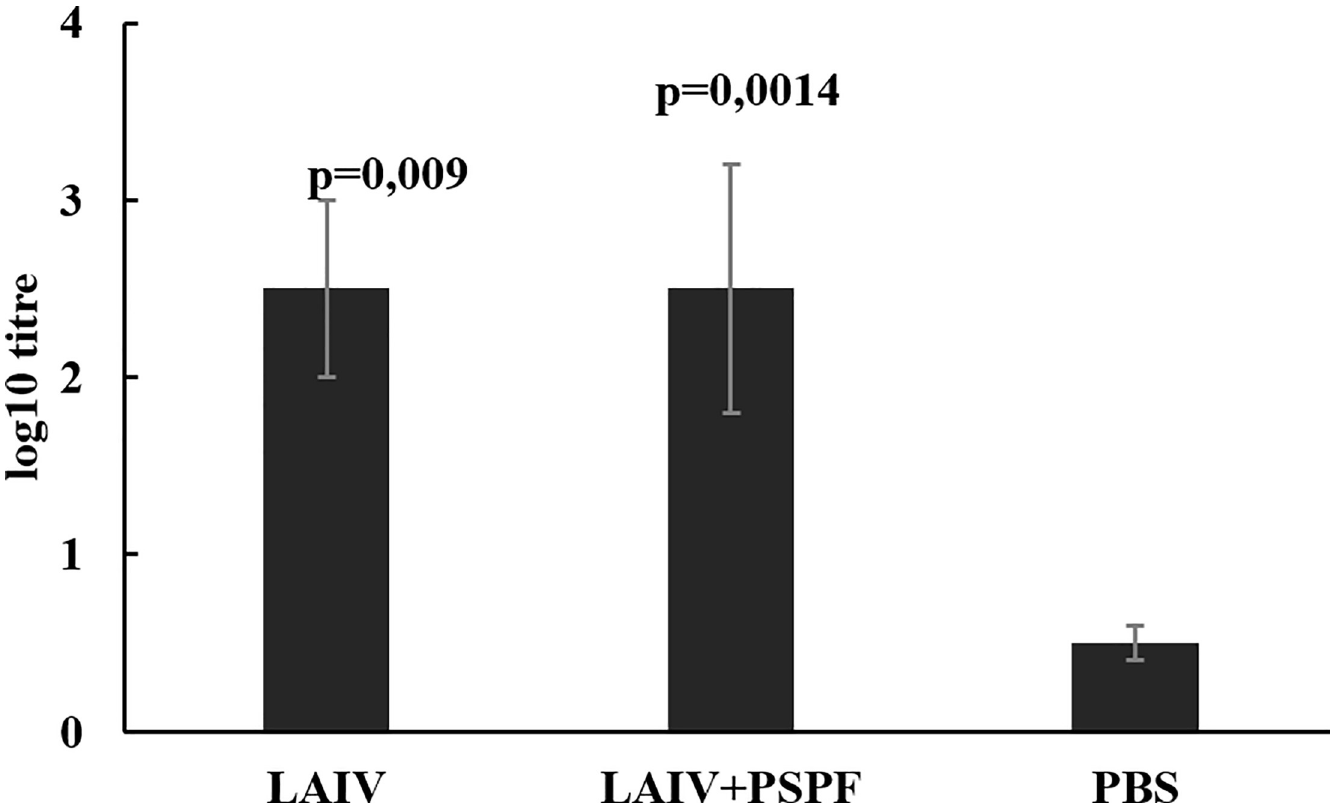
Fig 3. Virus-specific serum IgG immune responses in mice after primary vaccination and revaccination with LAIV or combined LAIV and PSPF vaccine. The whole purified A/New York/61/15 (H1N1) pdm virus was used for ELISA assay. Reciprocal antibody titers (n = 8) were expressed as log10 (ELISA) and presented as mean ± SEM; p-values provided are compared to mock-immunized animals